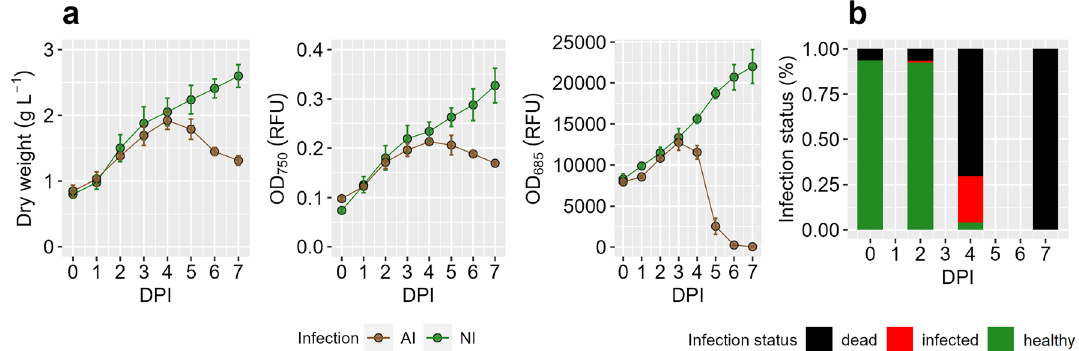
Figure 1. ( a ) Dry weight biomass content, optical density (OD 750 ), normalized chlorophyll a fluorescence (OD 685 ) of aphelid-infected (AI, brown) und non infected (NI, green) S. vacuolatus cultures over days post inoculation (DPI) (mean of n = 3 ± SD). ( b ) Mean of infection status was revealed by fluorescence microscopic observations from AI treatment over time (n =